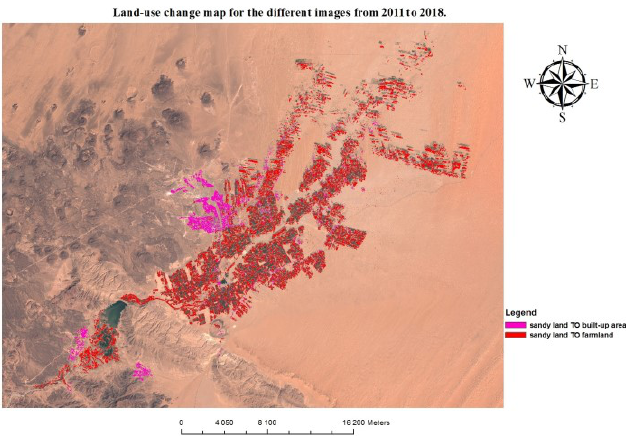
Fig.5. Geospatial distribution of LULC changes between 2001 and 2011.